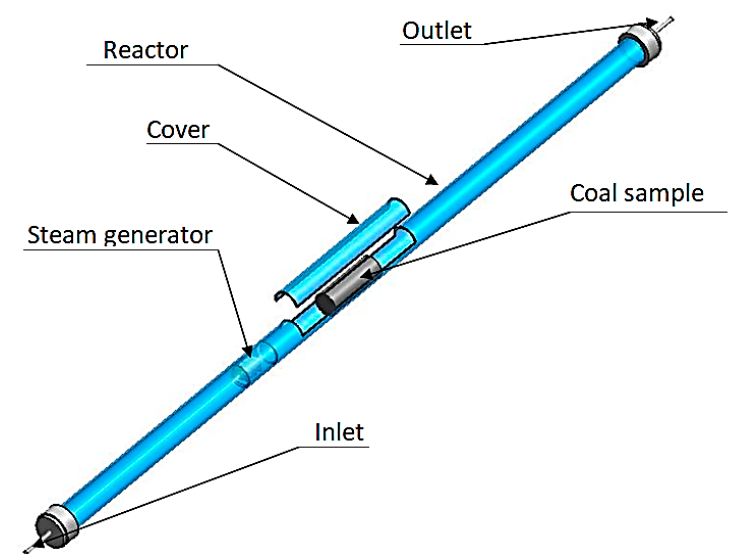
Figure 17. The three-dimensional (3D) model of the coal gasification reactor.